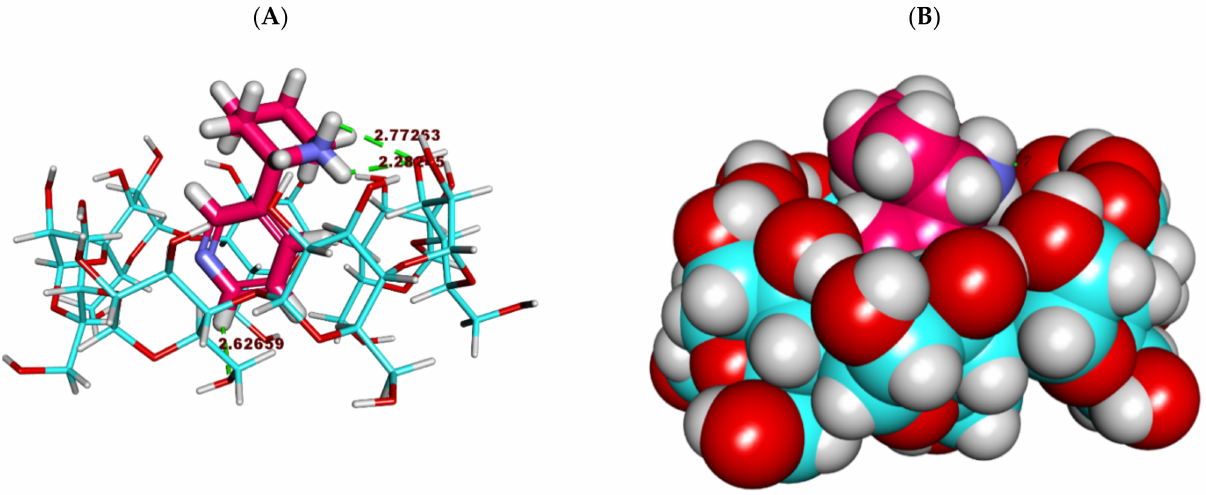
Figure 3. The best-ranked docking poses of anabasine with β CD, front view, as sticks ( A ), and CPK ( B ).